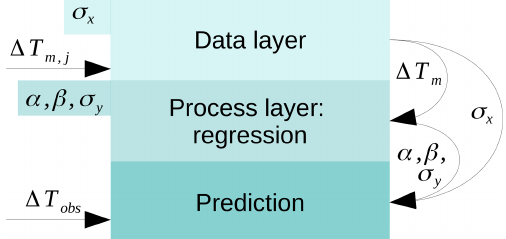
Figure A1. Schematic of the hierarchical Bayesian model em- ployed. The data layer models a best estimate of historical warm- ing for each model. With this estimate, a regression is performed between historical warming and TCR in the process layer. Using information from both layers and observed warming, a probability density function is estimated for TCR as the final